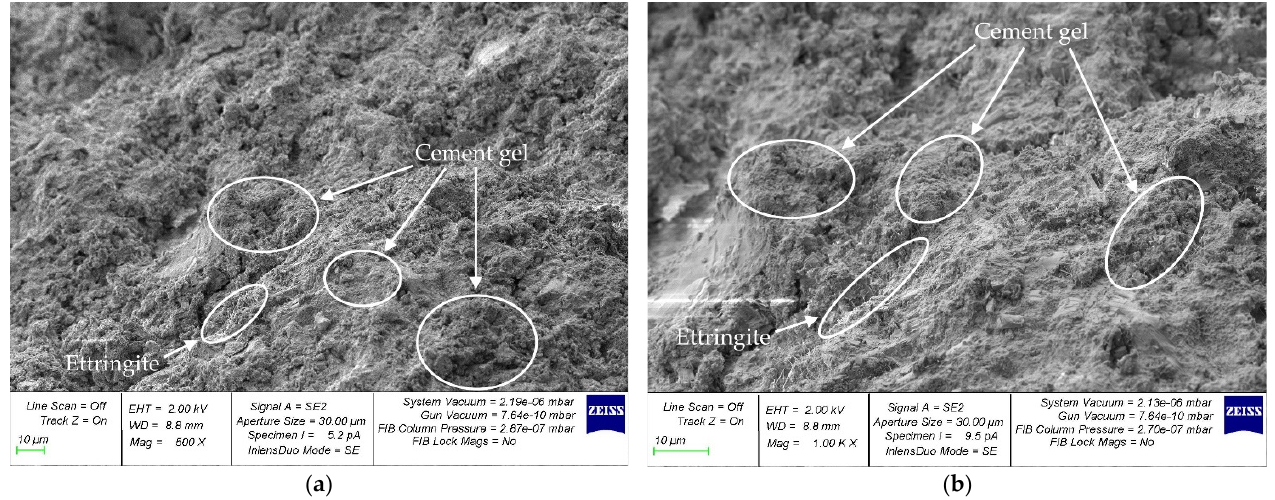
Figure 10. Vibrocentrifuged samples: ( a ) 500×; ( b ) 1000×.